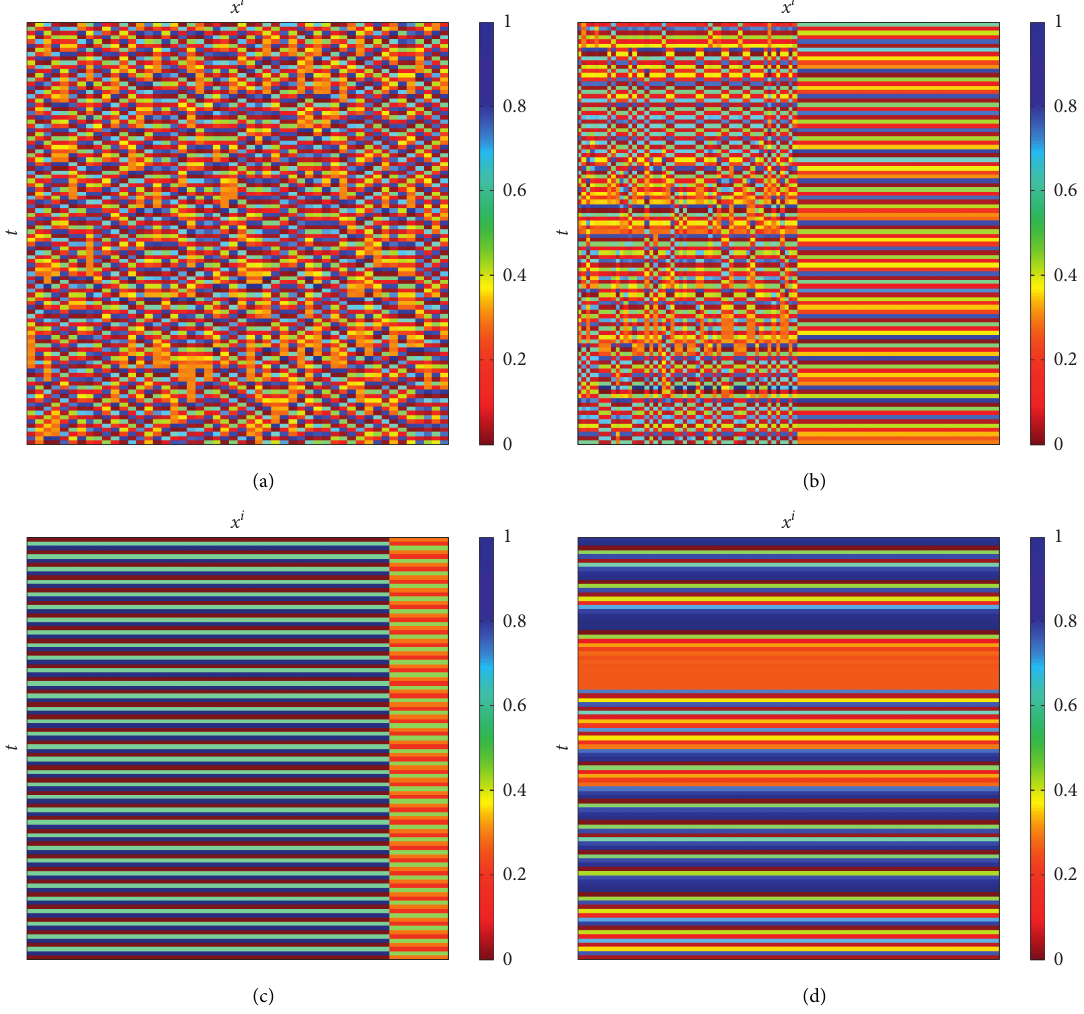
Figure 2: Asymptotic evolution of the states x i (horizontal axis) as a function of time (vertical axis) for system equations (7) and (9) with size N � 100 and fixed b � 0 . 5, for different values of the coupling parameter. Random initial conditions are uniformly distributed in the interval [ 0 , 1 ] . After discarding 10 4 transients, 100 iterates t are displayed. Ordering of the map indexes is explained in the text. Color code: two elements i,j share the same color if x i t � x j t . (a) Incoherent or desynchronized state, ε � 0 . 15. (b) Chimera state, ε � 0 . 2. (c) Two-cluster state, ε � 0 . 39. (d) Synchronization, ε � 0 .